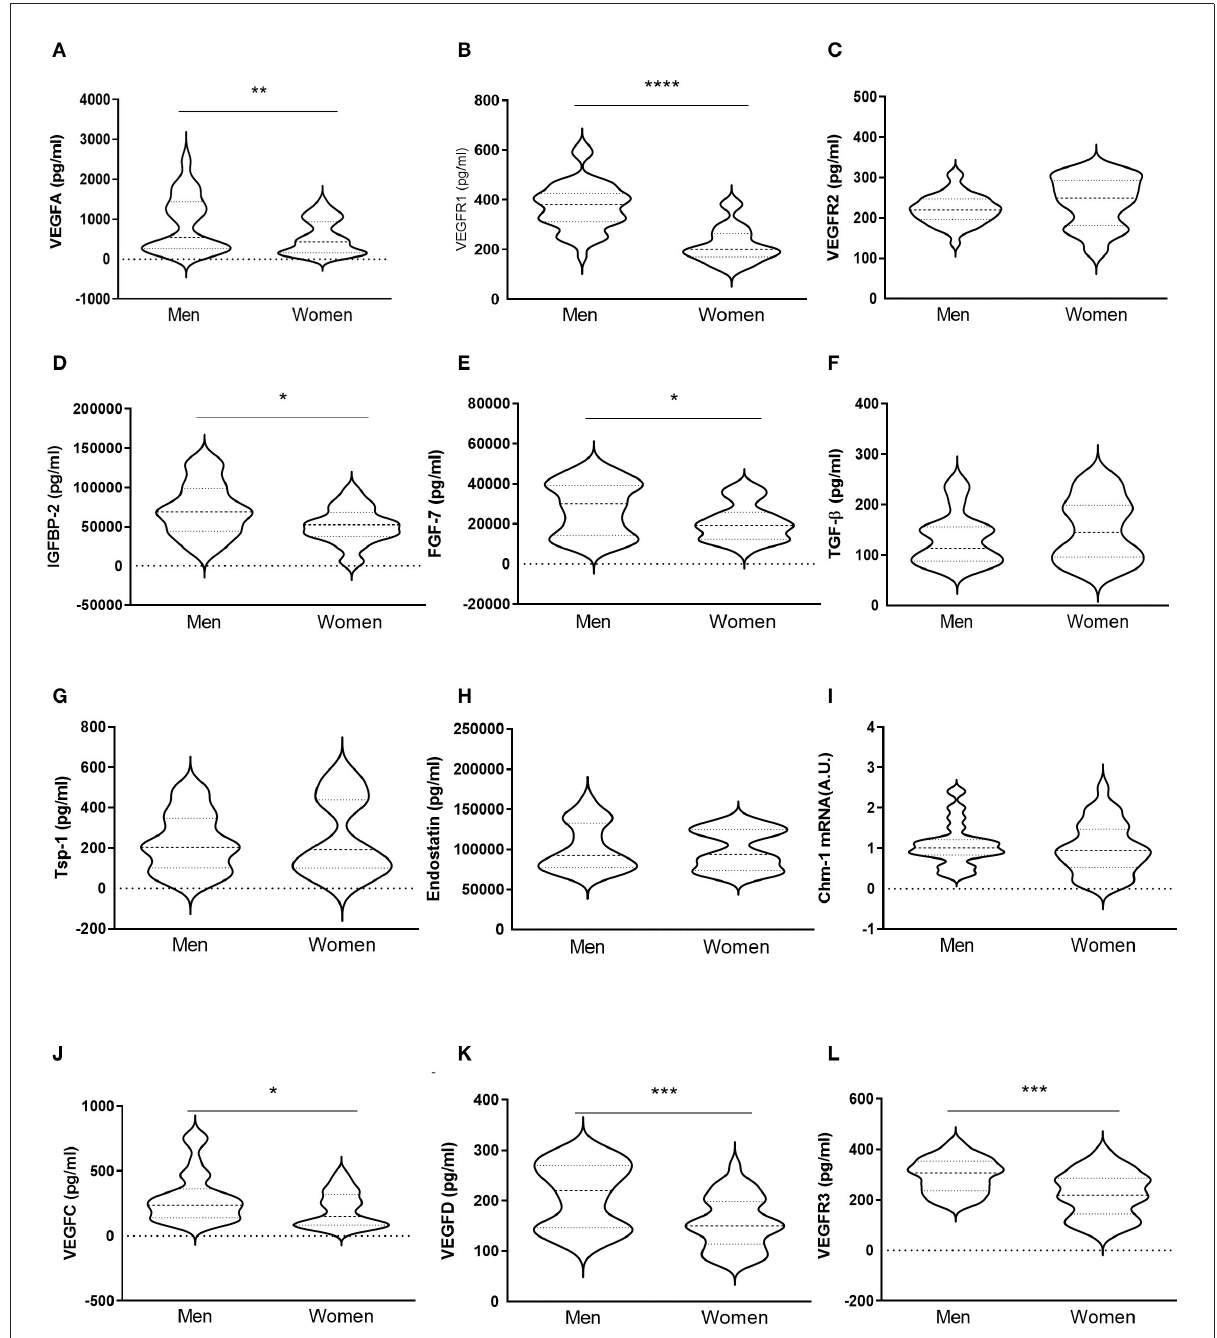
FIGURE5 In vitro sex-comparative analysis of pro-angiogenic, anti-angiogenic, and lymphangiogenic markers in human aortic VICs. Protein expression of pro-angiogenic factors VEGF-A, VEGFR1, VEGFR2, IGFBP-2, and FGF-7 in VICs isolated from male and female-derived AVs from AS patients (A–E) measured from the supernatant by ELISA. Protein levels of TGF- β , Tsp-1, and endostatin in VICs from AVs of AS patients (F–H) were determined from the supernatant by ELISA. mRNA expression levels of Chm-1 (I) . Protein expression of lymphangiogenic factors VEGF-C, VEGF-D, and VEGFR3 (J–L) in the supernatant by ELISA. VEGF: vascular endothelial growth factor; IGFBP: insulin-like growth factor binding protein; FGF: fibroblast growth factor; TGF- β : transforming growth factor-beta; Tsp: thrombospondin; Chm-1: chondromodulin-1. N = 24 for men and N = 12 for women. * p < 0.05 vs. men, ** p < 0.01 vs. men, *** p < 0.001 vs. men, **** p < 0.0001 vs. men.